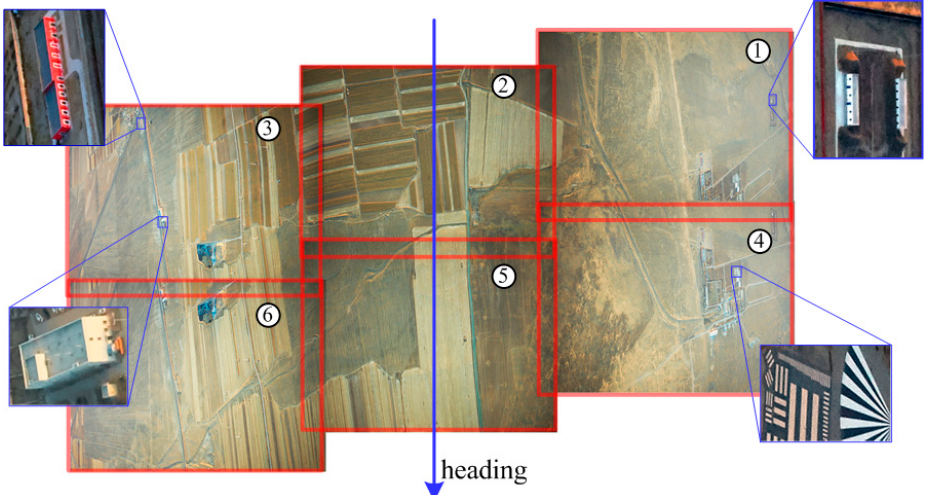
Figure 16. Series of mosaic images of two adjacent sweeping cycles. Table 2. Image attitude in sweep imaging mode.